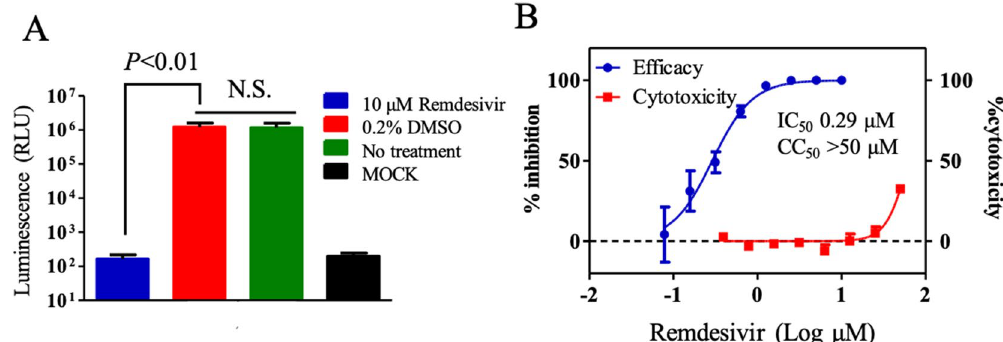
Figure 3. Antiviral evaluation using SARS-CoV-2 replicon. ( A ) Antiviral activity of remdesivir. The CHO-K1 cells electroporated with 5 μg of replicon RNA were seeded in a 96-well plate. The cells were treated immediately with 10-μM remdesivir or 0.2% DMSO. Luminescence was measured at 24 h post-treatment. The mean and standard error of two independent experiments are shown in this figure. A one-way ANOVA was performed